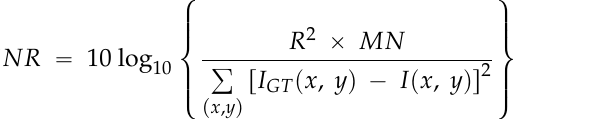
Table 1. Comparison of the results in Figure 8.